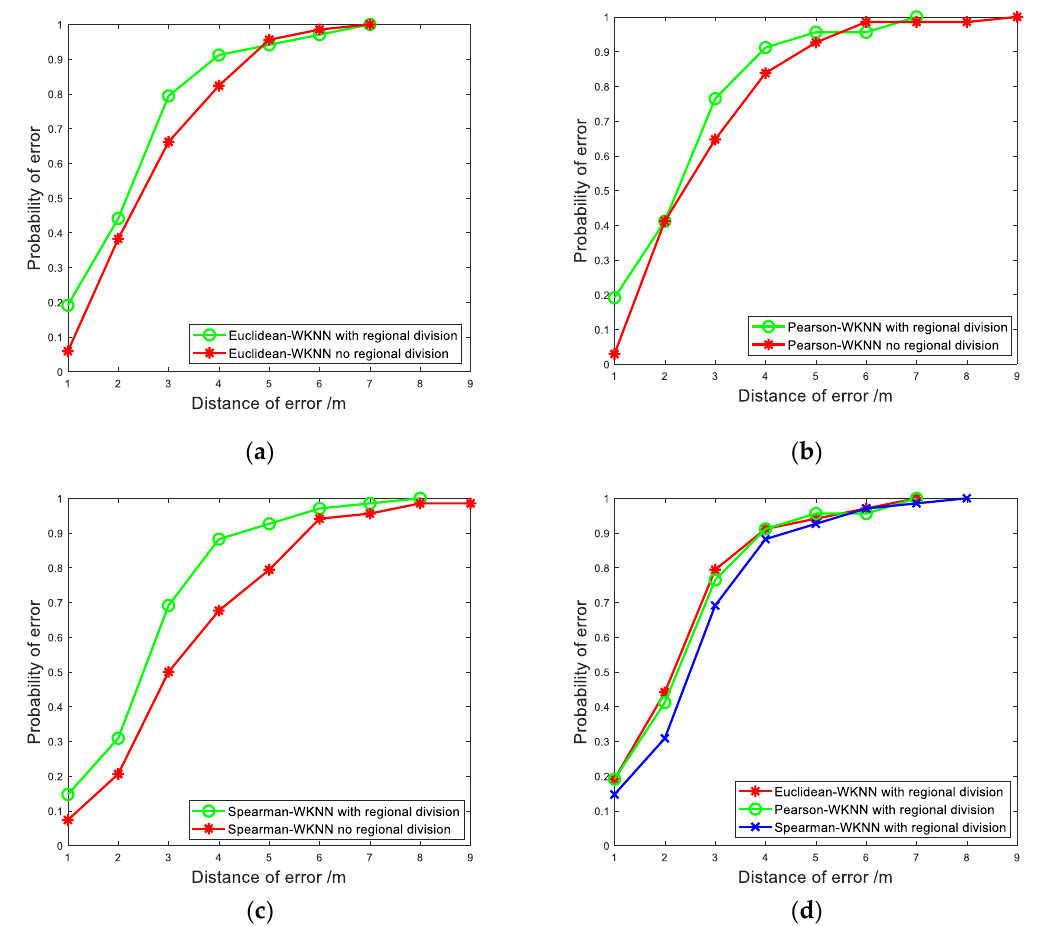
Figure 8. Figure 8. Probability of error: ( a ) Euclidean distance, ( b ) PCC, ( c ) Spearman c oefficient, ( d ) Regional division.